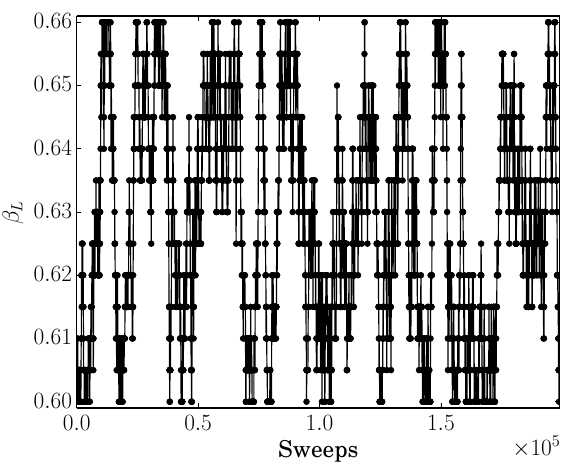
Figure 3 . Time evolution of β L for N = 21 during a time window which is accumulated statistics. On the horizontal axis the time is reported in number of sweeps.